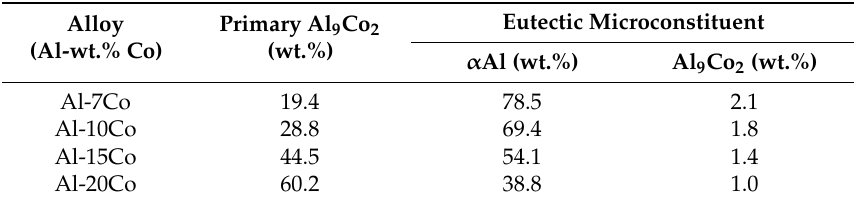
Table 1. Expected percentages of the microconstituents of the Al‐Co alloys when prepared under equilibrium conditions.